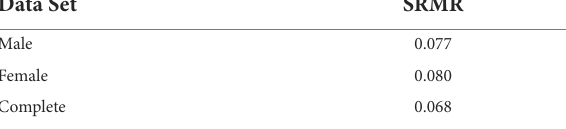
TABLE 4 Model Fit using SRMR.